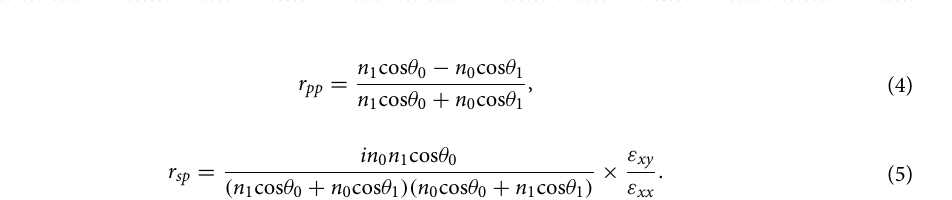
Figure 4. Change in magnetic domain structures due to an applied external magnetic field for Al 2 O 3 /CoPt/ AZO trilayer shown in Fig. 3. ( a ) Common polar Kerr loop and ( b – h ) MFM images under external magnetic fields of 0 (after DC demagnetization), 0.5, 0.75, 1.0, 1.25, 1.5, and 2.0 kOe, respectively. Red closed circles in ( a ) show each MFM measurement